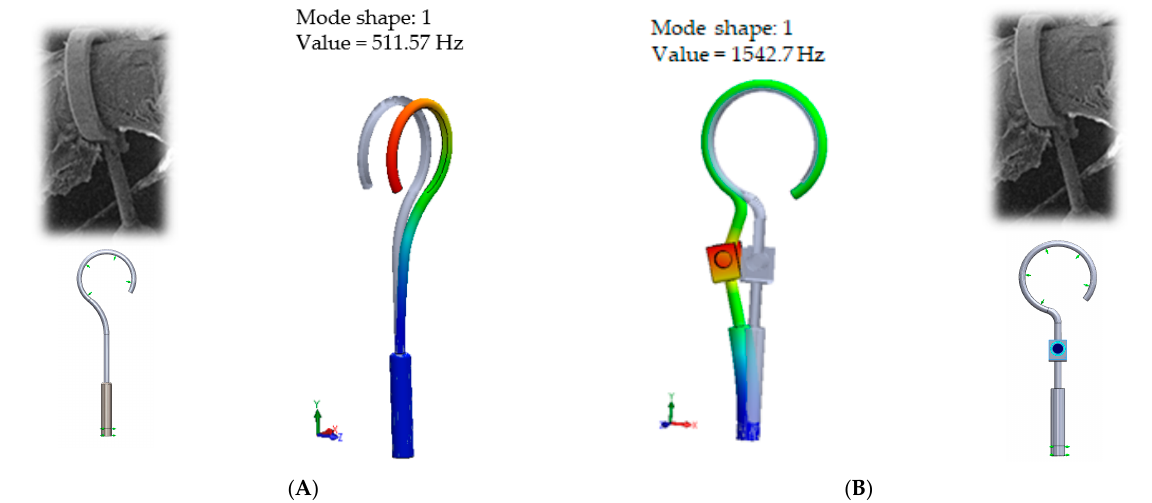
Figure 7. The results of modal analysis of target fixing of prosthesis. ( A ) standard stapes prosthesis, ( B ) modified stapes prosthesis.